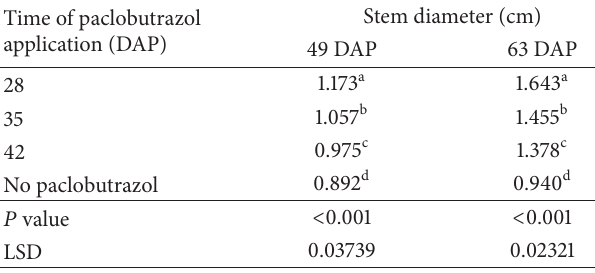
Table 3: Effect of time of paclobutrazol application on potato stem diameter (cm) at 49 and 63 DAP.